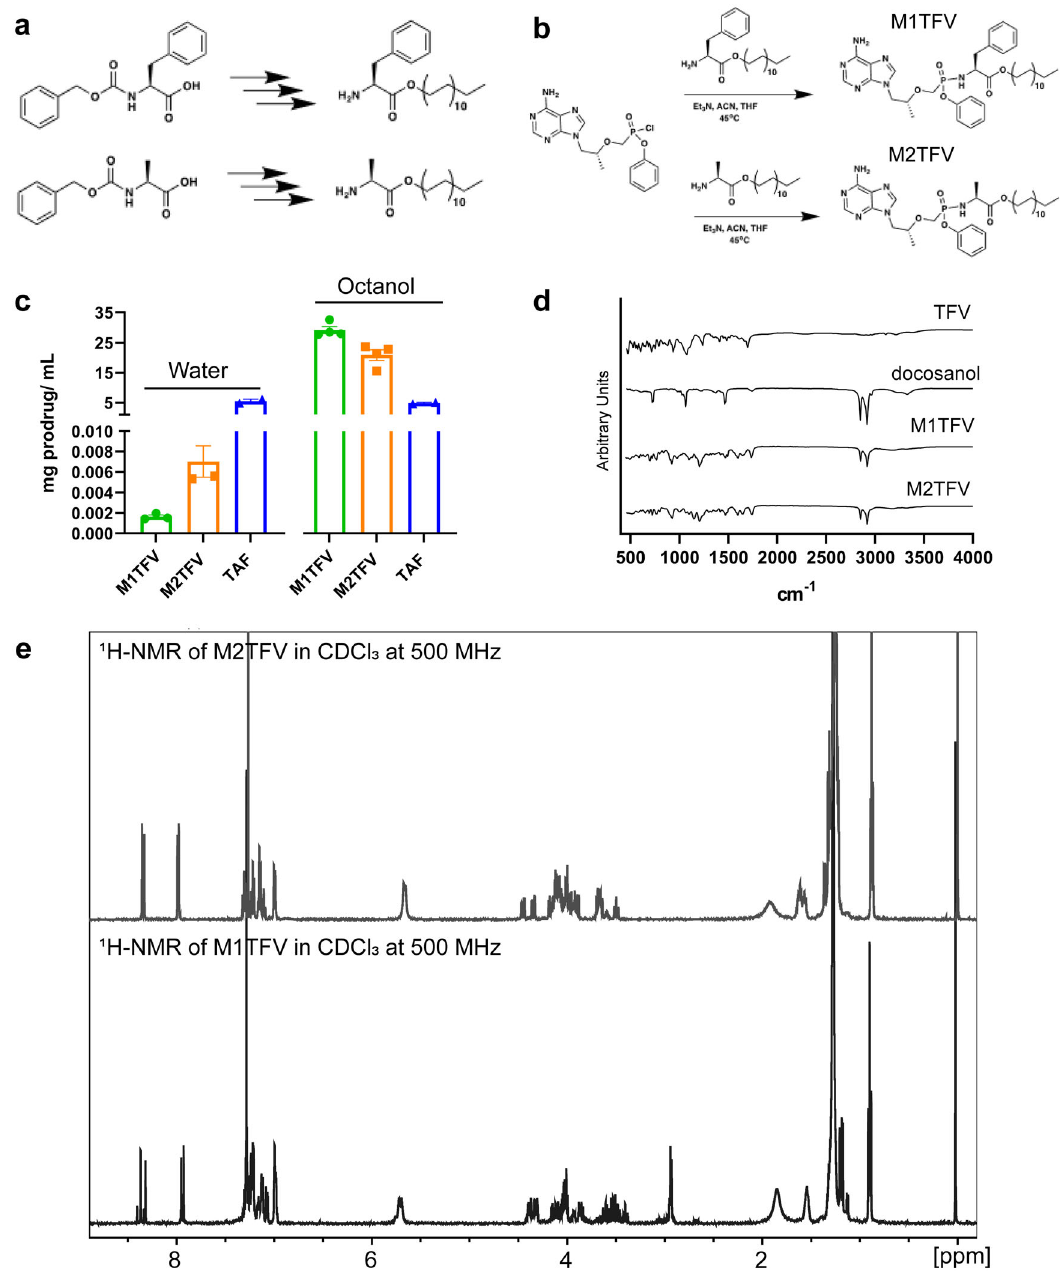
Fig. 1 Characterization of TFV ProTides. a Synthesis of phenyl alanine and alanine derivatizing promoieties. b Conjugation of the amino acid esters to activated monophenyl TFV to form M1TFV and M2TFV prodrugs. c Aqueous and octanol solubility of M1TFV and M2TFV demonstrate the decreased aqueous solubility of M1TFV (green) and M2TFV (orange), and increased octanol solubility compared to TAF (blue). Values reported are the mean ± SEM of three replicates. d FT-IR Absorption bands at 2,844 and 2,912 cm − 1 illustrate the asymmetric and symmetric C-H stretches from the long chain fatty acid. e An overlay of the proton NMR spectra con fi rmed the synthesis of M1TFV (below) and M2TFV (above). Speci fi cally, the triplet peak at 0.87 ppm and multiplets at 1.21 – 1.35 ppm correspond to the terminal methyl and methylene protons of the docosyl ester on M1TFV, respectively. Chemical shifts at 7.04 − 7.38 ppm represent the aryl and phenylalanine masking promoieties. For M2TFV, the triplet at 0.87 ppm and multiplets at 1.20 – 1.38 ppm correspond to the terminal methyl and methylene protons of the docosyl ester, respectively. Chemical shifts at 6.99, 7.10, 7.14, 7.21, and 7.31 ppm represent the aryl masking promoiety. a − e Experiments were repeated independently fi ve times with equivalent